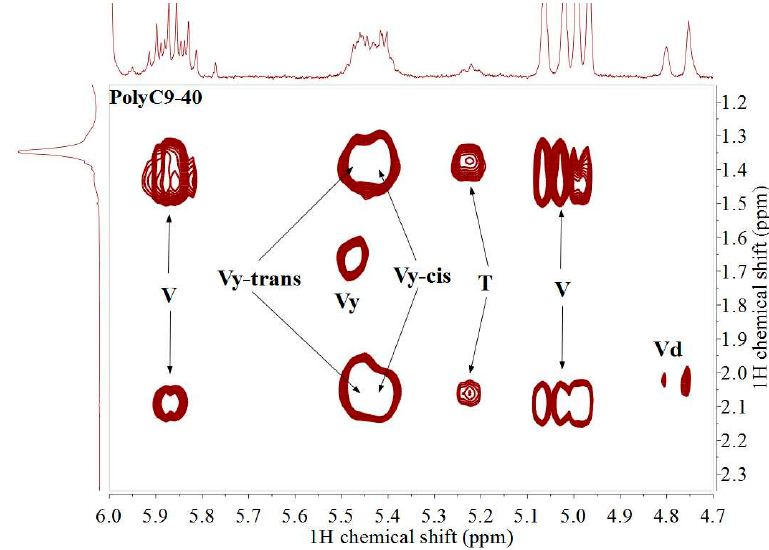
Figure 10. Evolution of V y and T contents with the C 9 feeding molar fraction for the different series.